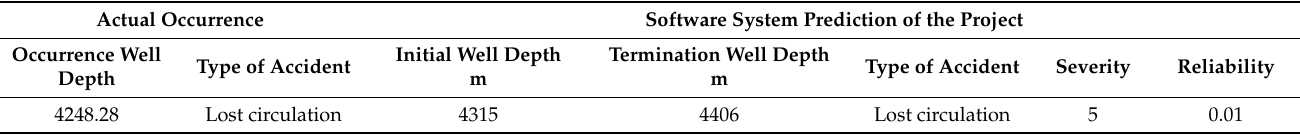
Table 3. Early warning result data of Yuanba 272H well accident.